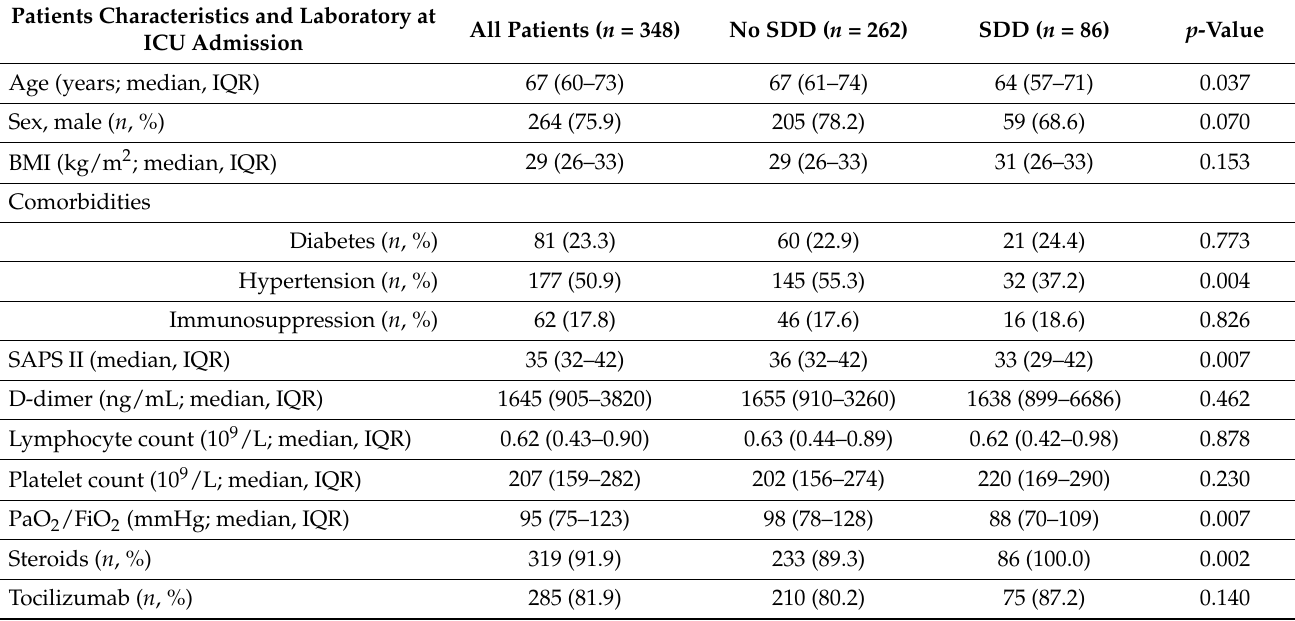
Table 1. Demographics, comorbidities, severity scores, and laboratory at ICU admission in all patients and in patients with or without selective digestive decontamination. The use of steroids during ICU stay and of tocilizumab before and during ICU stay are also reported.